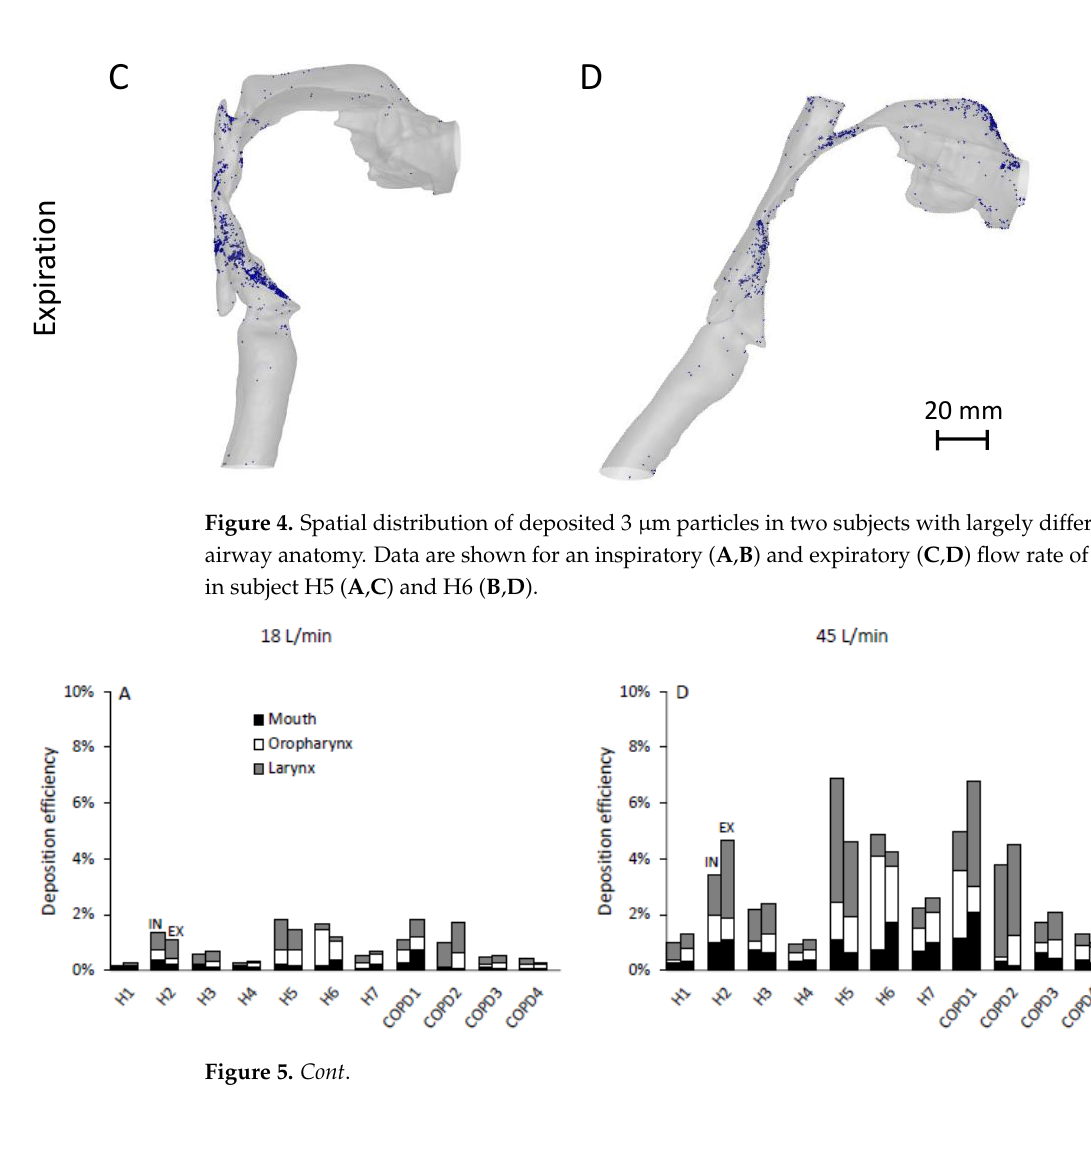
Figure 5. Comparison of deposition occurring during inhalation (IN) and exhalation (EX) in the different subregions of the oral airway. Deposition for 1, 3 and 5 µm particles are shown in top ( A , D ), middle ( B , E ) and lower panels ( C , F ), respectively. Deposition at a flow rate of 18 L/min and